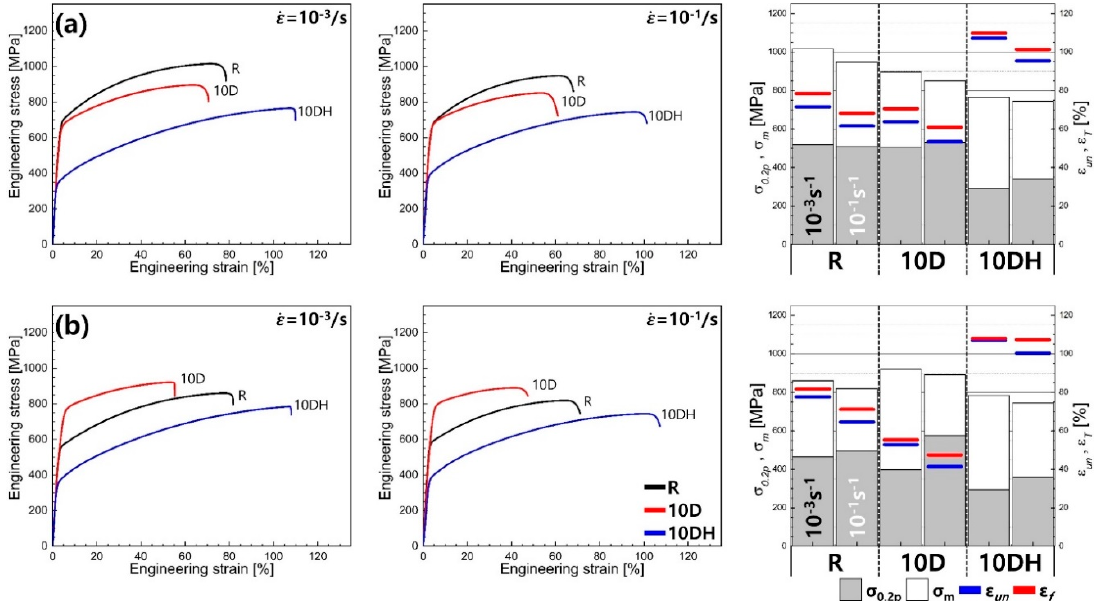
Figure 8. Engineering stress–strain curves and mechanical properties diagram of the ( a ) base metal and ( b ) weld metal. All specimens were strained along the welding direction.